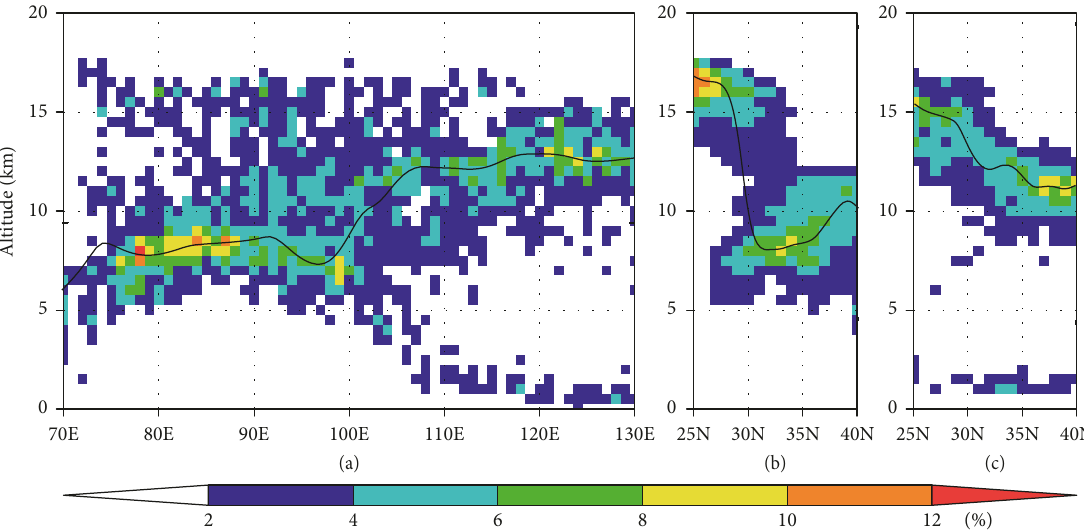
Figure 4: Cross sections of occurrence of CTH along longitude (a) averaged between 30 ° N and 35 ° N and latitude (b) averaged between 80 ° E and 95 ° E and (c) averaged between 110 ° E and 120 ° E. The thick solid line represents the height of maximum